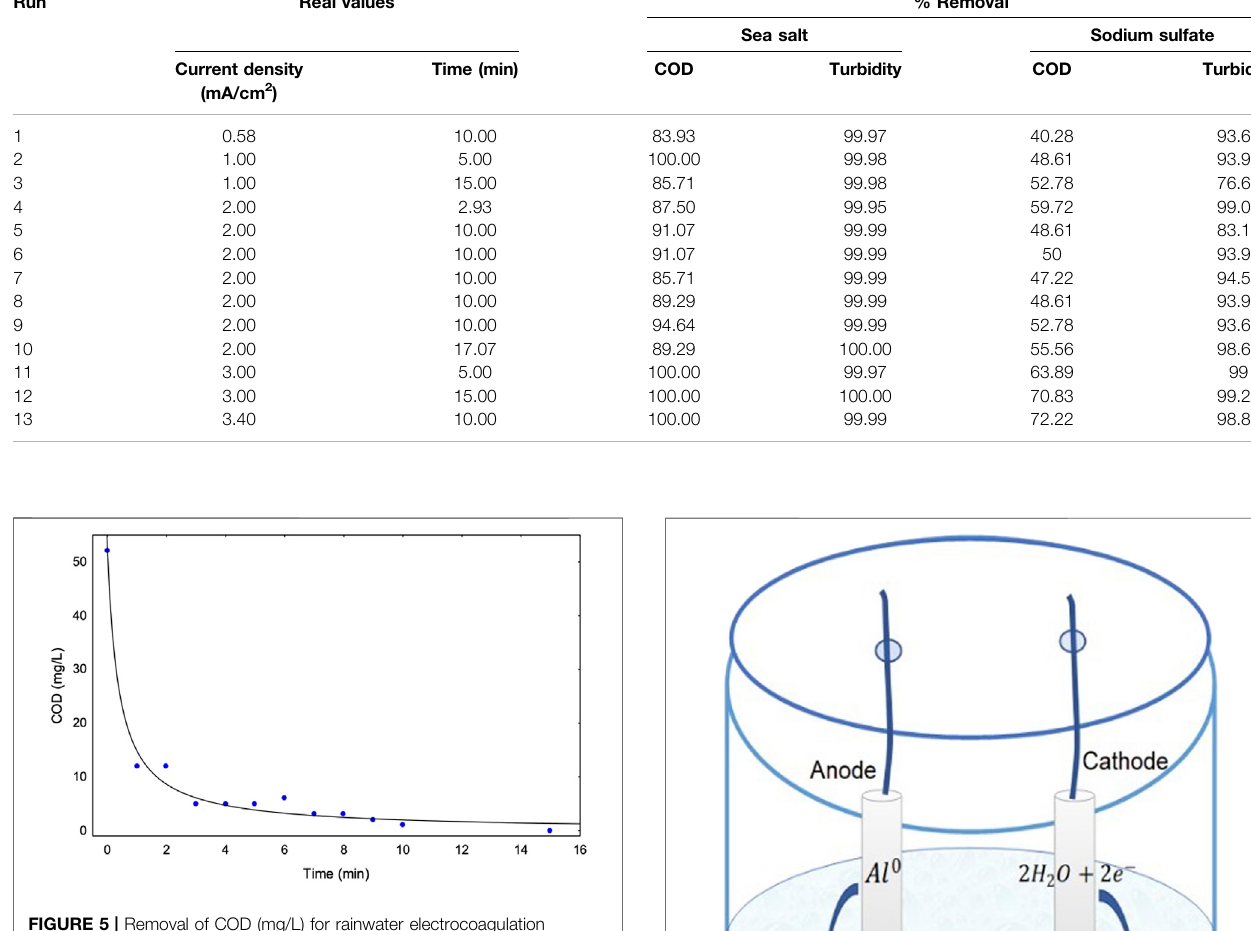
FIGURE 5 | Removal of COD (mg/L) for rainwater electrocoagulation process. COD 0 = 52 mg/L at initial pH 6.55, treatment time 15 min, at 0.15A and 72 mg/L Al(OH) 3 dose.